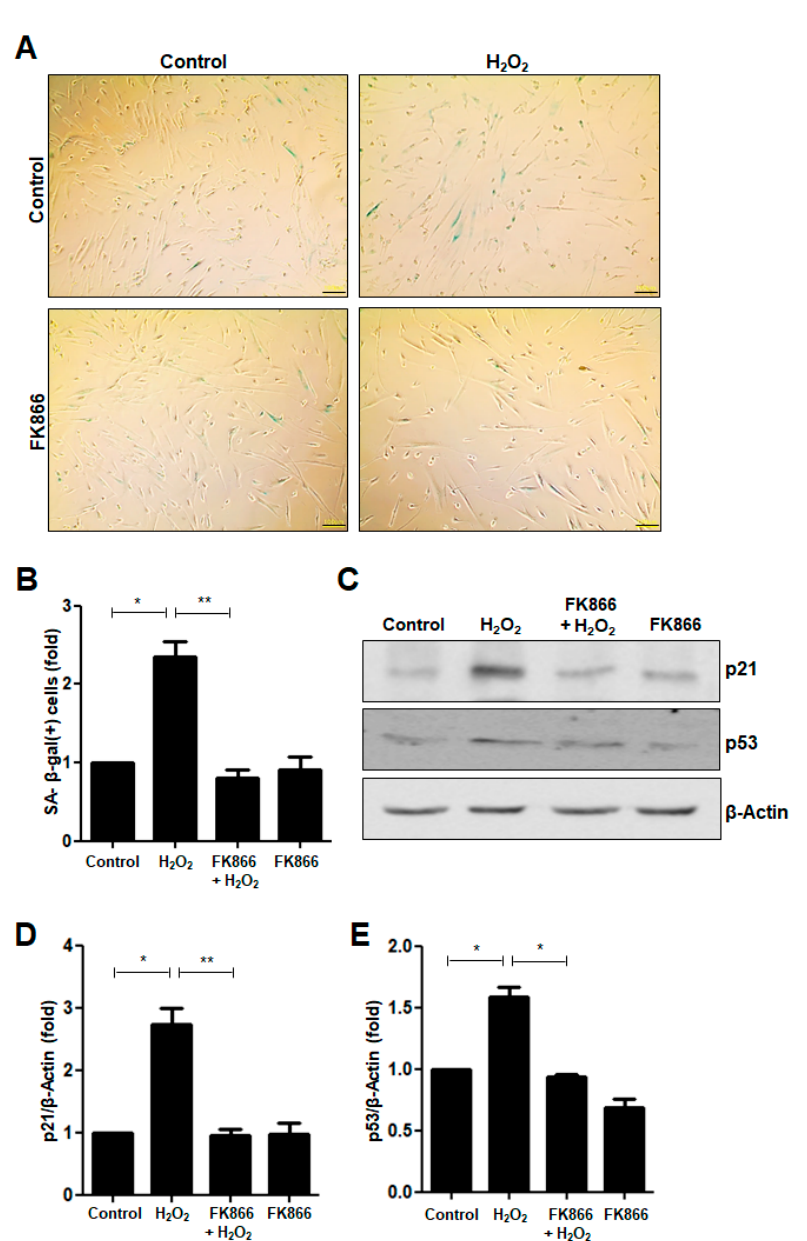
Figure 1. Effect of FK866 on H 2 O 2 -induced premature senescence in hDPCs. ( A ) The hDPCs were stimulated with H 2 O 2 (400 nM) for 24 h and stained for detecting the activity of senescence-associated (SA)- β -galactosidase. Representative image of SA- β -galactosidase staining. Scale bar: 100 μ m. ( B ) Quantitative results for the percentage of cells stained positively with SA- β -galactosidase. ( C ) The hDPCs were pretreated with FK866 (10 μ M) for 2 h and then stimulated with H 2 O 2 (400 nM) for 24 h. Cell extracts were subjected to Western Blot analysis for detecting the levels of the p21 and p53 proteins. β -Actin was used as the loading control. ( D , E ) Densitometric analysis for assessing the relative protein levels were normalized to the levels of β -Actin: D, p21; E, p53. * p < 0.1, ** p < 0.01. The change in the fraction of SA- β -gal(+) cells among the H 2 O 2 -treated hDPCs was evalu- ated by detecting the expression of the p21 and p53 proteins, which are well-known senescence markers. H 2 O 2 increased the protein levels of p21 (Figure 1C,D) and p53 (Figure 1C,E) in hDPCs. When pretreated with FK866 before H 2 O 2 treatment, the H 2 O 2 -induced increase in the levels of p21 and p53 proteins was significantly attenuated (Figure